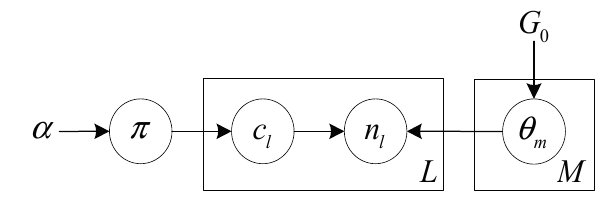
Figure 2. Dirichlet process mixture